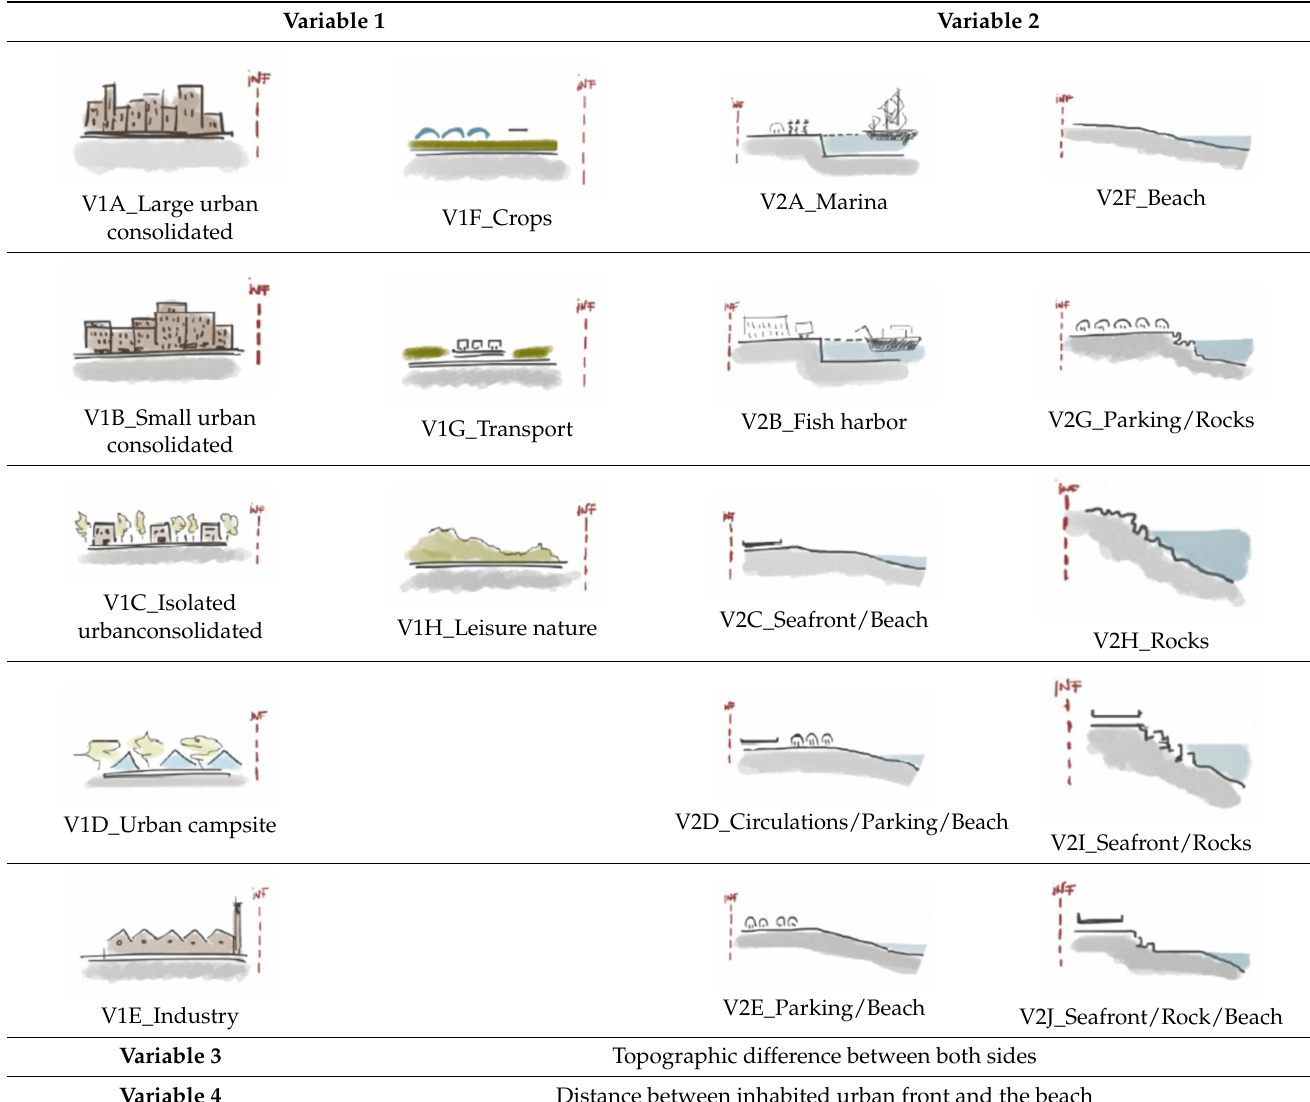
Table 3. Classification of the action variables and landscape elements (Source: authors’